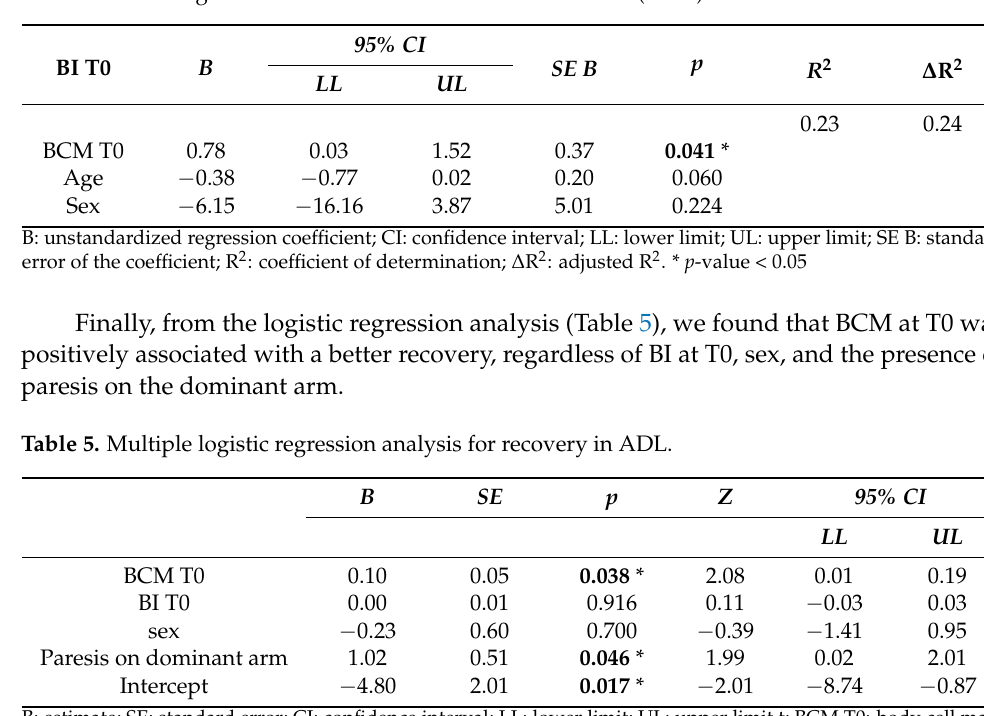
Table 4. Linear regression results for Barthel index at baseline (BI T0).